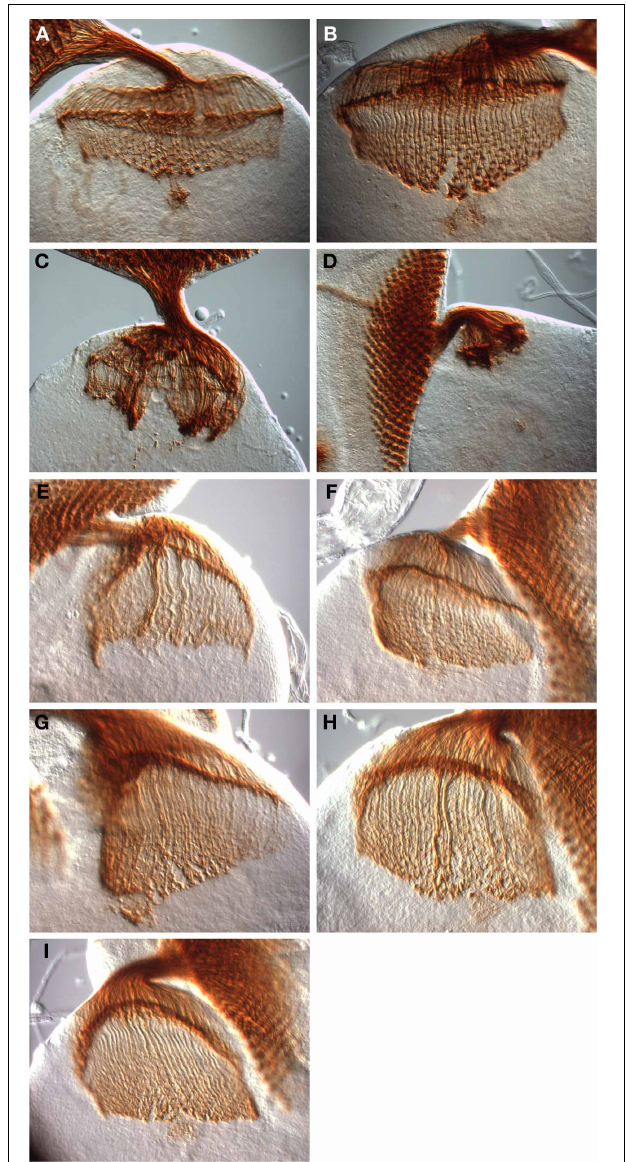
FIGURE 5 | Rescue of dinr -associated axon guidance defects by full-length DInR and variants. Third instar larval eye-brain complexes were stained with MAb24B10 to visualize differentiated photoreceptors and their axons. Imaging was done with DIC optics and a 40 × objective. (A,B) Control eye-brain complexes of the genotype w 1118 . The specimen shown in (B) is at a later stage of development than that shown in (A) . The rip in the medulla in (B) resulted during sample preparation. (C,D) Axon guidance was severely disrupted in eye-brain complexes from whole animal dinr ex15/273 transheterozygotes. (E) Axon guidance defects were rescued with full-length DInR. (F–I) Axon guidance defects were rescued by expression of DInR variants: (F) DInR-LESL; (G) DInR-Y2F; (H) DInR-LESL, Y2F; (I)